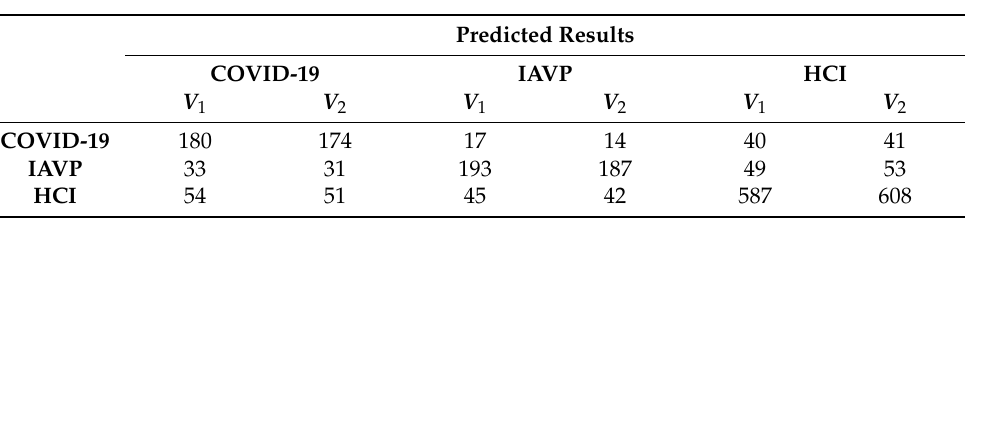
Table 1. Computation of a 3 × 3 confusion matrix on three attributes as COVID-19, IAVP and a healthy candidate without infection (HCI). The features specified in the presented areas of the V-NET and VNET-RPN models are represented through V 1 and V 2 .